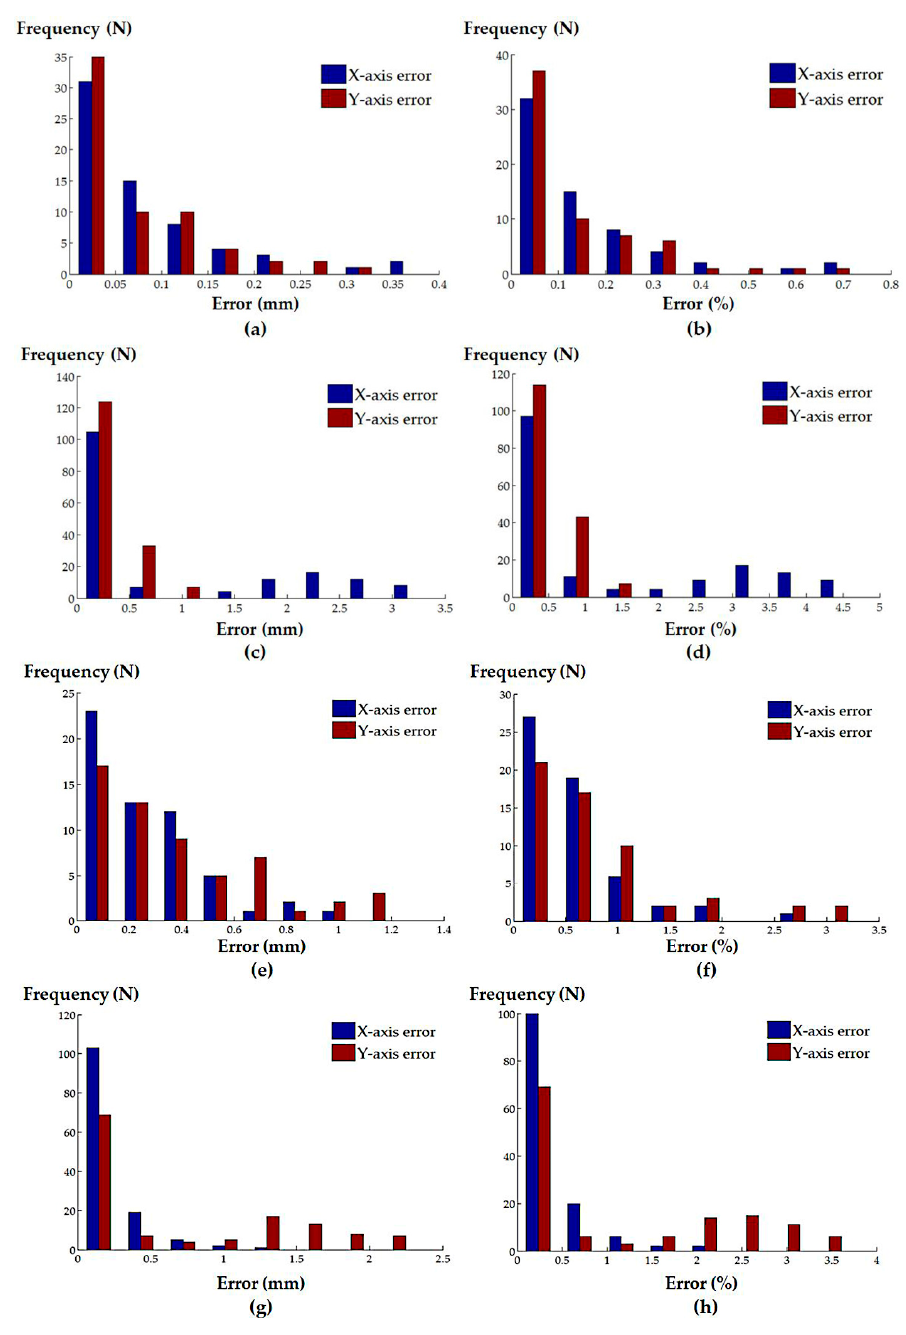
Figure 9. Histograms of the ( a ) absolute and ( b ) normalized positioning errors for the simulated atrial septal defect repair procedure; ( c ) absolute and ( d ) normalized positioning errors for the simulated left atrial ablation procedure; ( e ) absolute and ( f ) normalized positioning errors for the simulated mitral valve repair/replacement procedure; ( g ) absolute and ( h ) normalized positioning errors for the simulated trans-catheter aortic valve replacement procedure.